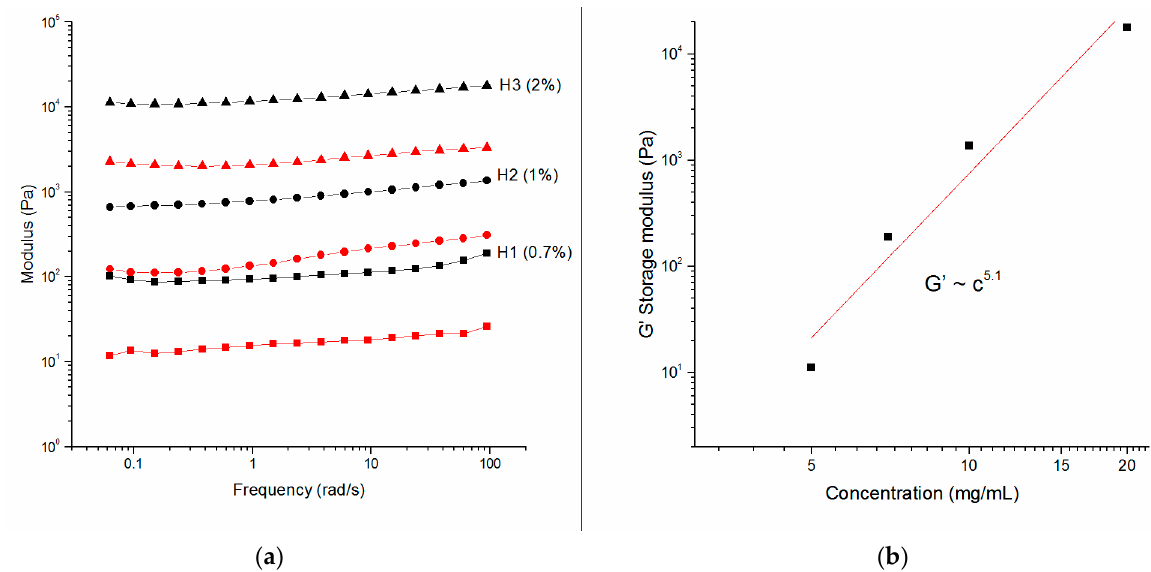
Figure 2. Rheology of hydrogels at different concentration of P5. ( a ) Dynamic frequency sweep at 0.1% of strain of H1 ( ▲ ), H2 ( ● ), and H3 ( ■ ) hydrogels. Black symbols report storage moduli (G’), while red symbols report loss moduli (G”); ( b ) storage modulus (G’) at 0.2% strain and 9.4 rad s − 1 as a function of concentration of P5